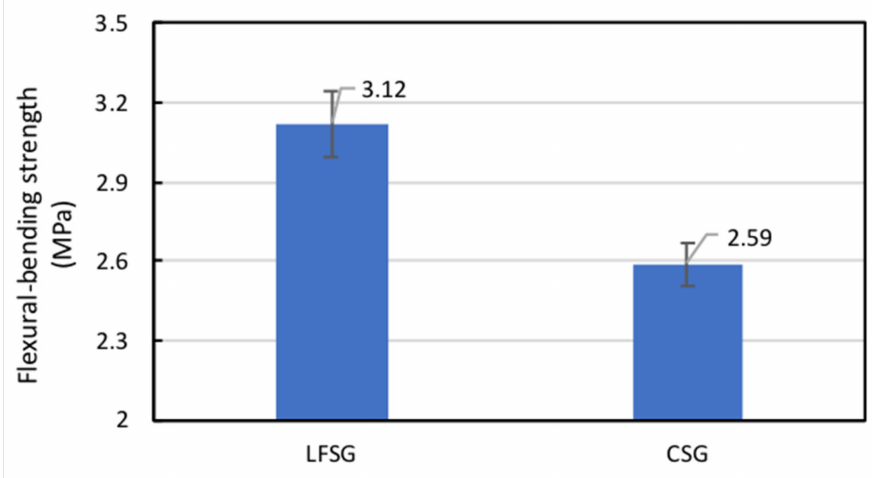
Figure 6. Flexural-bending strength of CSG and